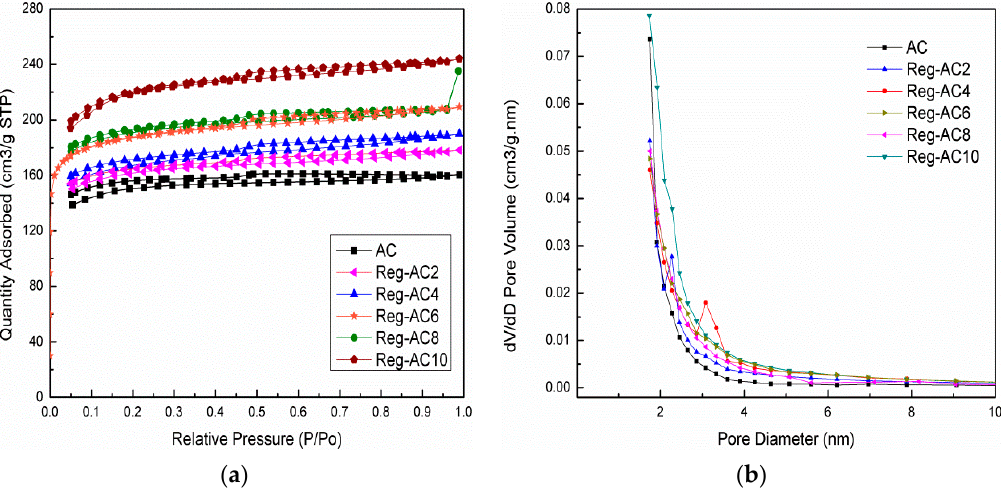
Figure 3. The N 2 sorption isotherms ( a ) and pore size distributions ( b ) of the samples (where AC. stands for fresh AC, Reg-ACn stands for the nth regenerated AC).